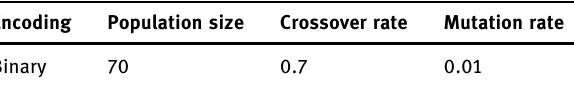
Table 2: Fundamental parameters of GA